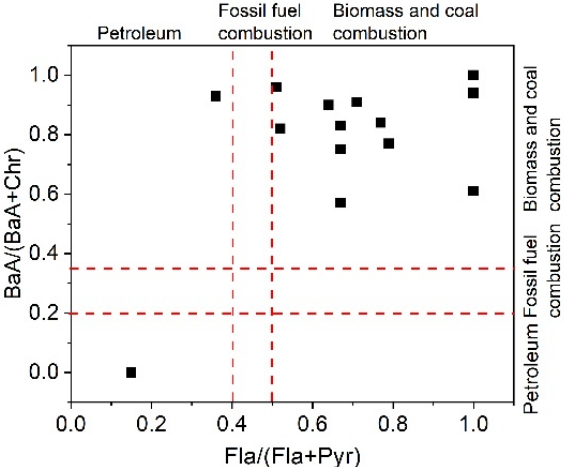
Figure 4. Ratios of PAH compounds in the Danshui River.